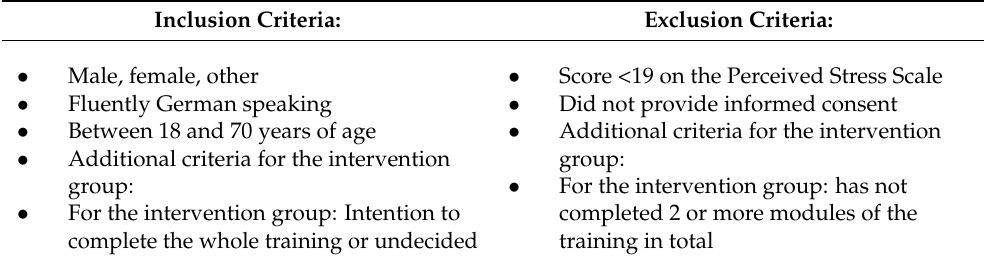
Table 2. Criteria for including or excluding study participants.